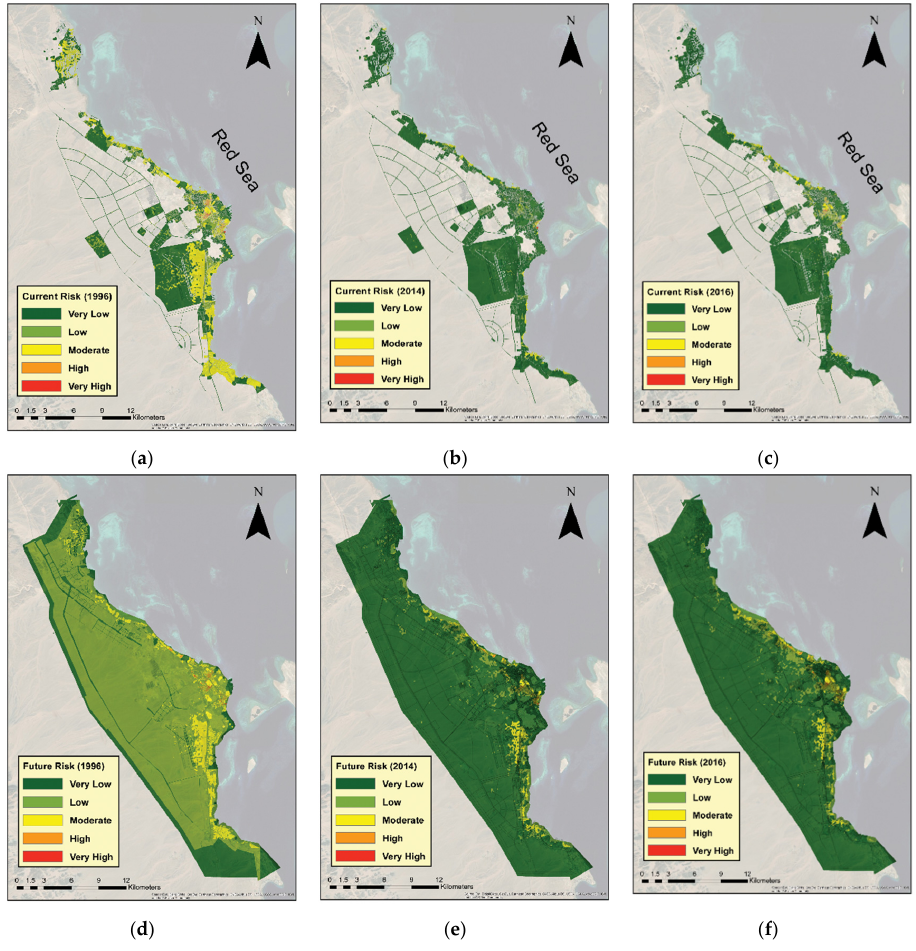
Figure 9. Flood risk maps for Hurghada for the events in 1996 (50-year REP) ( a ), 2014 (5-year REP) ( b ), and 2016 (10-year REP) ( c ) for the current situation and ( d – f ) for the future situation in the 2027 CSP, respectively.